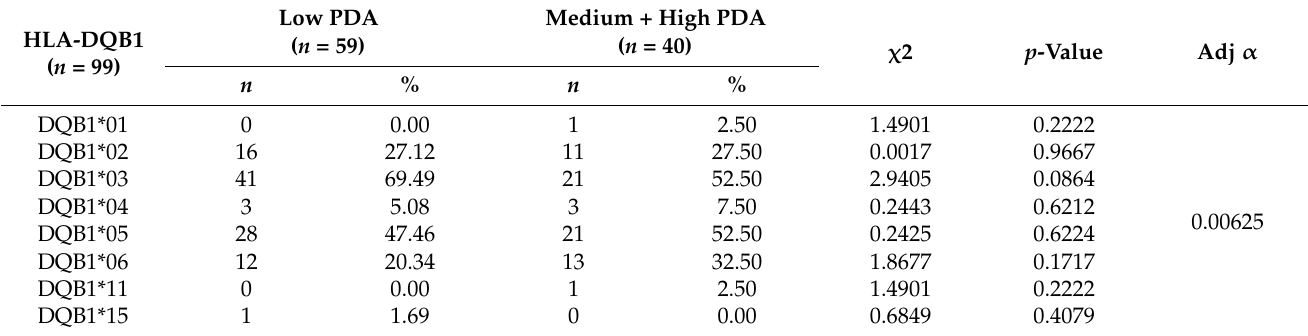
Table 5. Correlation between PDA and